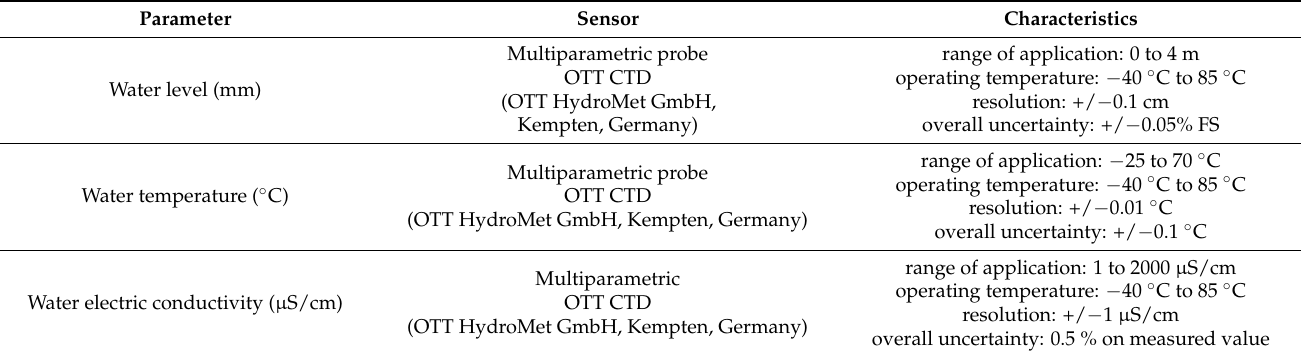
Table 3. Spring outflow